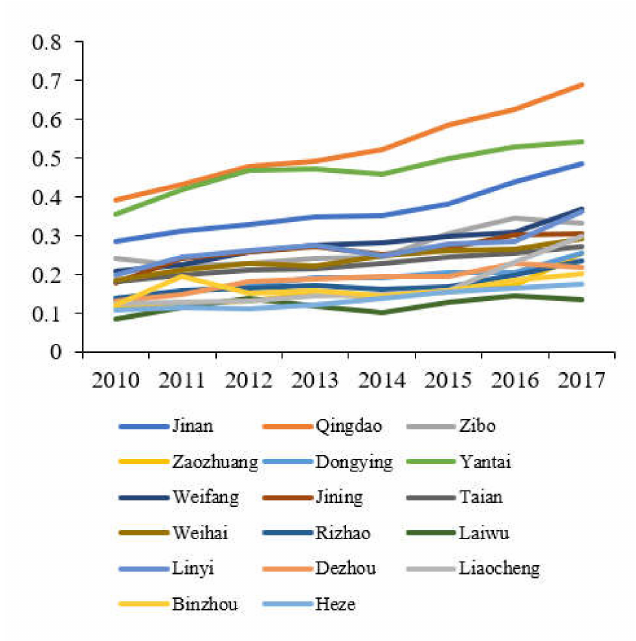
Figure 4. Comprehensive development indexes of the three systems of cities in Shandong Province.